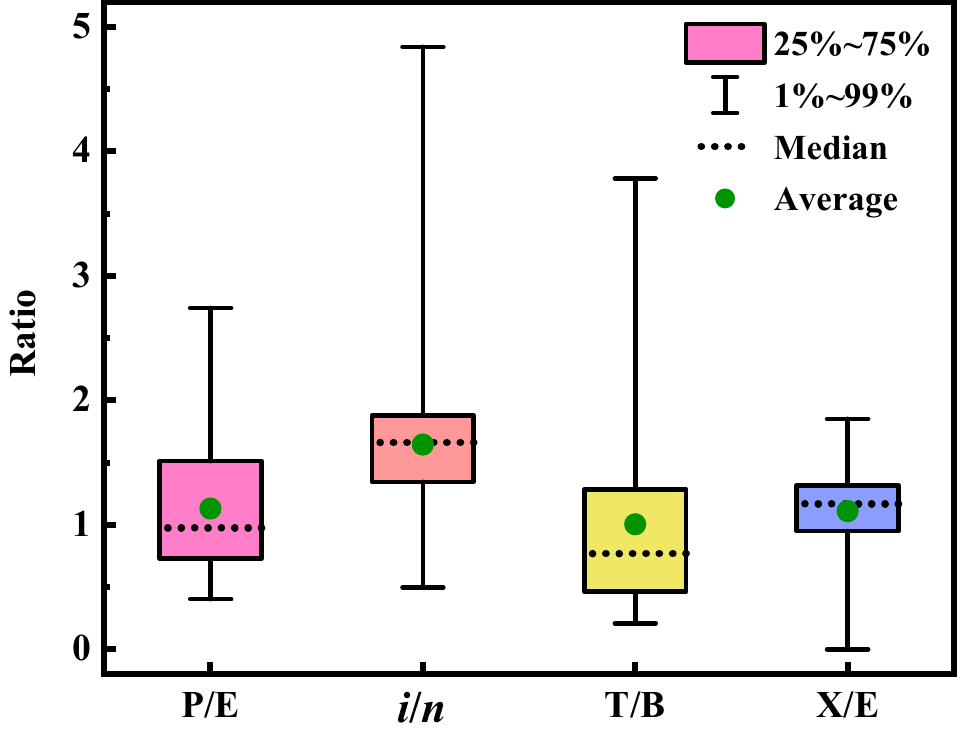
Figure 4. The ratio (unit: ppb/ppb) of propane/ethane (P/E), i -pentane/ n -pentane ( i / n ), toluene/benzene (T/B), and m/p-xylene/ethylbenzene (X/E) during the observation period. The T/B ratio at about 0.3 is for combustion sources, 0.9~2.2 for vehicle exhaust, and 1.4~5.8 for solvent usage sources [37,48,49]. As depicted in Figure 4, the T/B ratio was mainly distributed between 0.46~1.29, with an average value of 1.0 ± 0.77, indicating that the VOCs near the sampling site had the characteristics of combustion and traffic source emissions. However, the correlation between toluene and benzene was poor (Figure S2), with a correlation coefficient ( R 2 ) of 0.15, suggesting that the sources of toluene and benzene differed significantly. The X/E ratio is often used to indicate the degree of air mass aging [50–52]. The small X/E ratio revealed a high degree of air mass aging, which could be attributed to the influence of air mass transport. Generally, an X/E ratio in the range of 2.5~2.9 is an attribute of typical urban environments. If the ratio is much smaller than 2.9, the VOCs are impacted greatly by long-distance transmission [53,54]. The correlation coefficient between m / p -xylene and ethylbenzene in this study was 0.74 (Figure S2), implying that the VOC sources had a high consistency. As demonstrated in Figure 4, the average value of X/E was 1.11 ± 0.36, much lower than 2.9, highlighting the role of long-distance transport in VOC